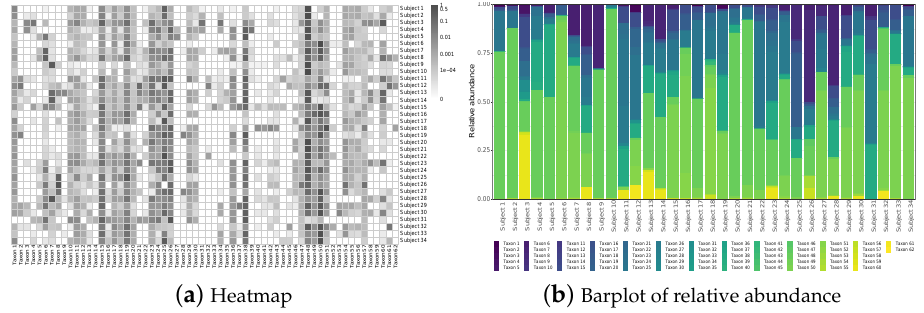
Figure 1. The NICU data: Heatmap and barplot of the relative abundance